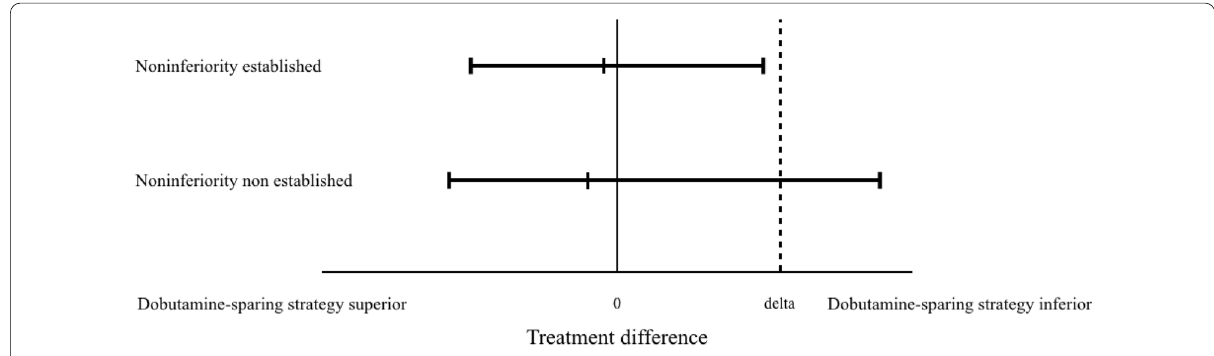
Fig. 1 Graphical representation in noninferiority trial if efficacy is measured by failure rates (lower is better). Delta: margin of